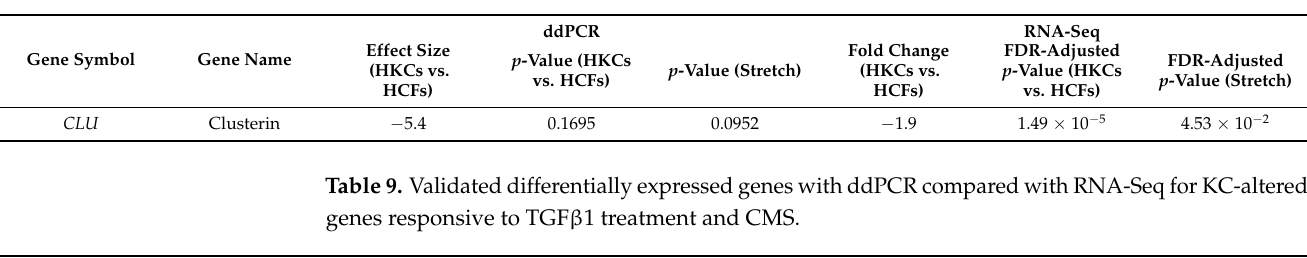
Table 8. Validated differentially expressed genes with ddPCR compared with RNA-Seq for KC-altered genes responsive to CMS.